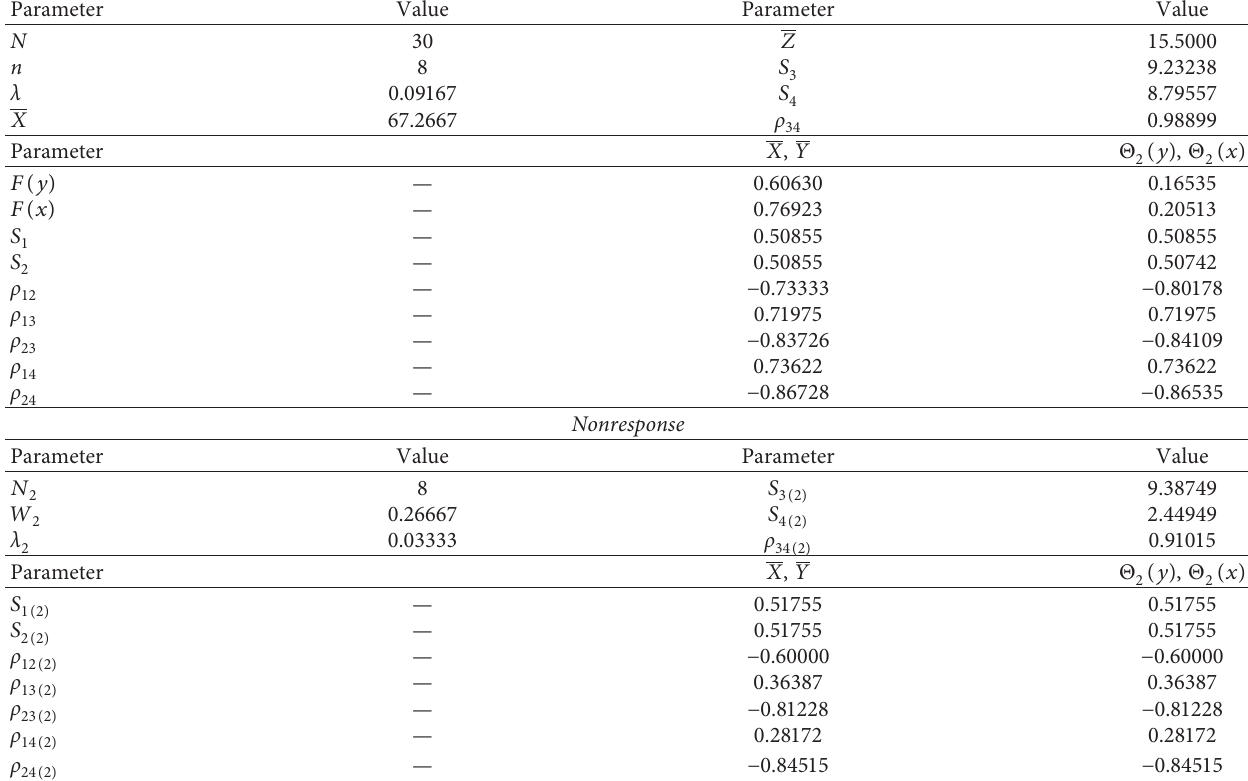
Table 3: Summary statistics for population I.